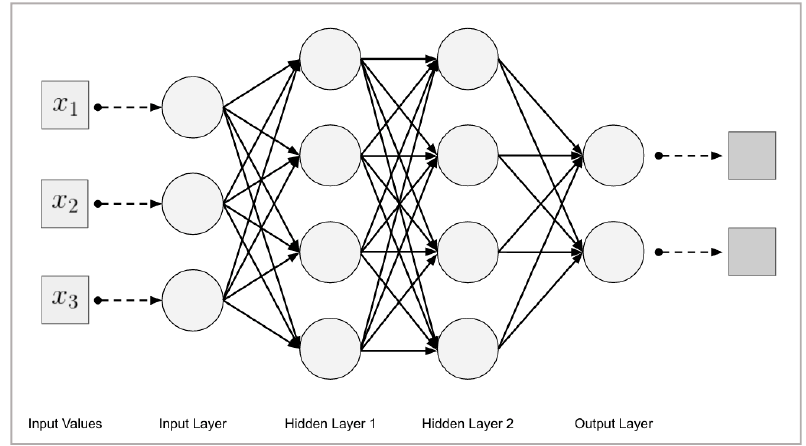
Figure 1. Feed-forward multilayer neural network [26.